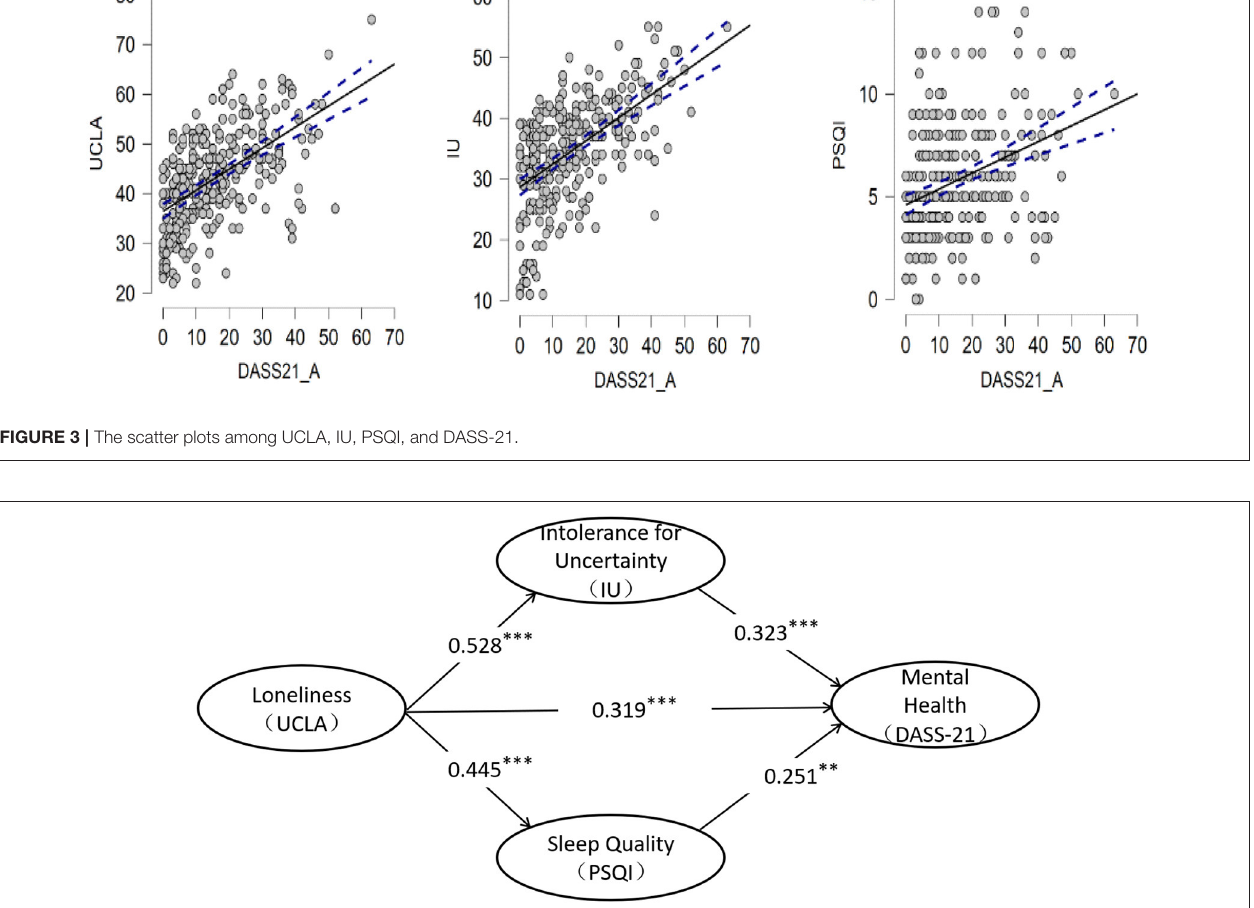
intolerance → mental health level, standardized path coefficient: 0.528 × 0.333 = 0.170 ∗∗∗ , hypothesis 2 holds; → sleep quality → mental health level, standardized path coefficient: 0.445 × 0.251 = 0.112 ∗ , hypothesis 3 holds;